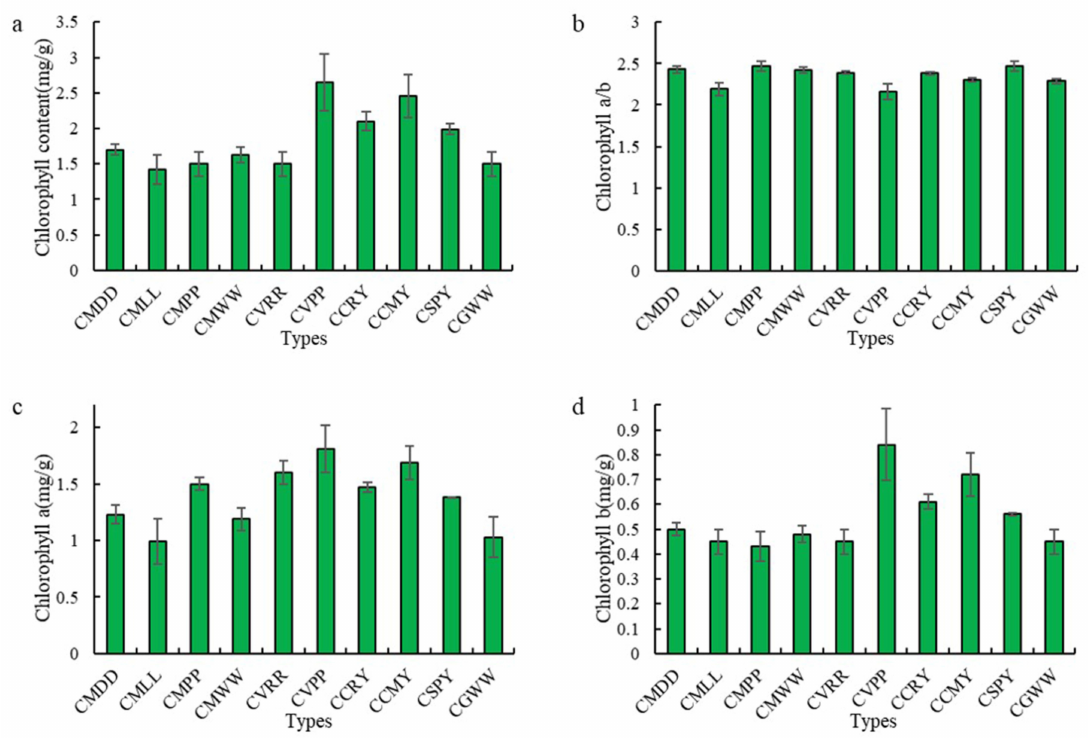
Figure 2. ( a ) Chlorophyll content of 10 Cypripedium samples. ( b ) Chlorophyll a/b ( c ) Chlorophyll a ( d ) Chlorophyll